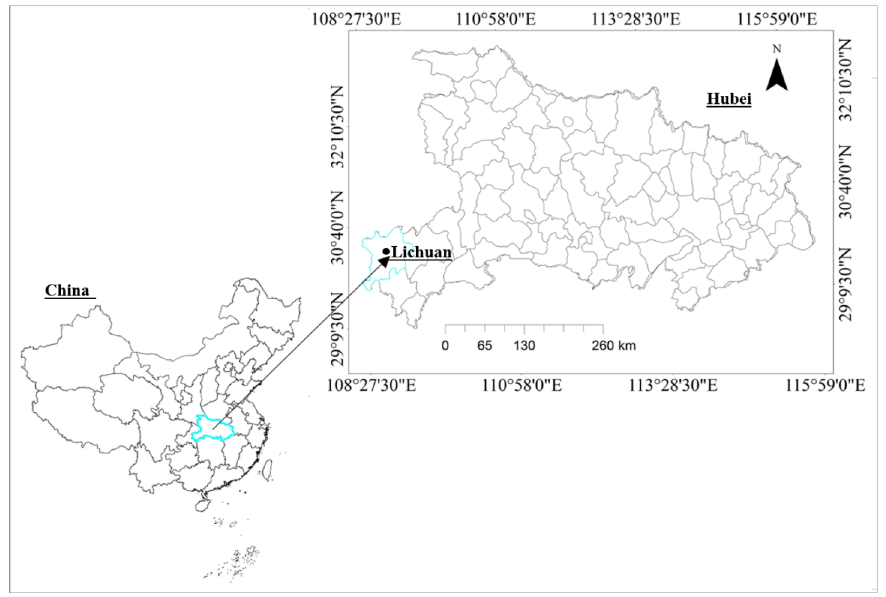
Fig 1. Geographic location of sampling sites. doi: 10.6084/m9.figshare.4956284.g001.